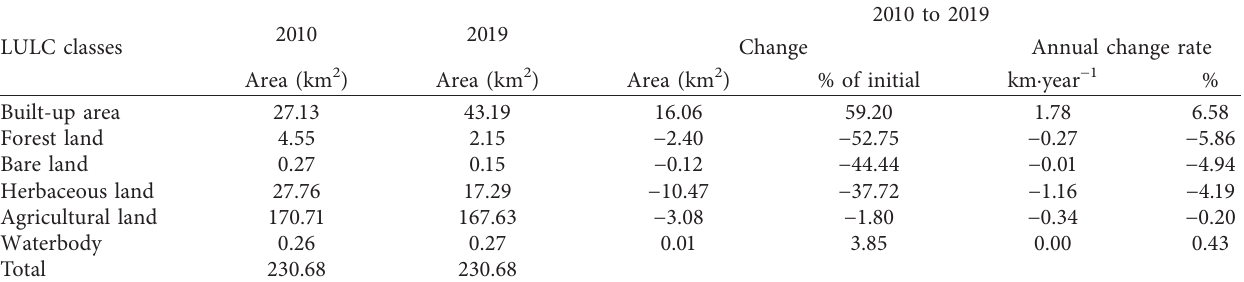
Table 8: LULC class annual change rate from 2010 to